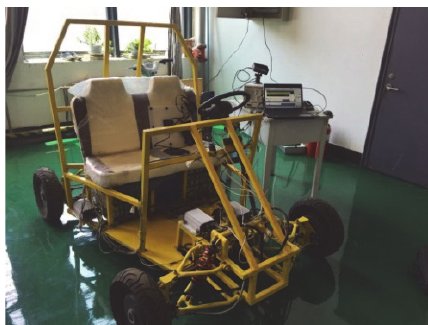
Figure 10: Road test.